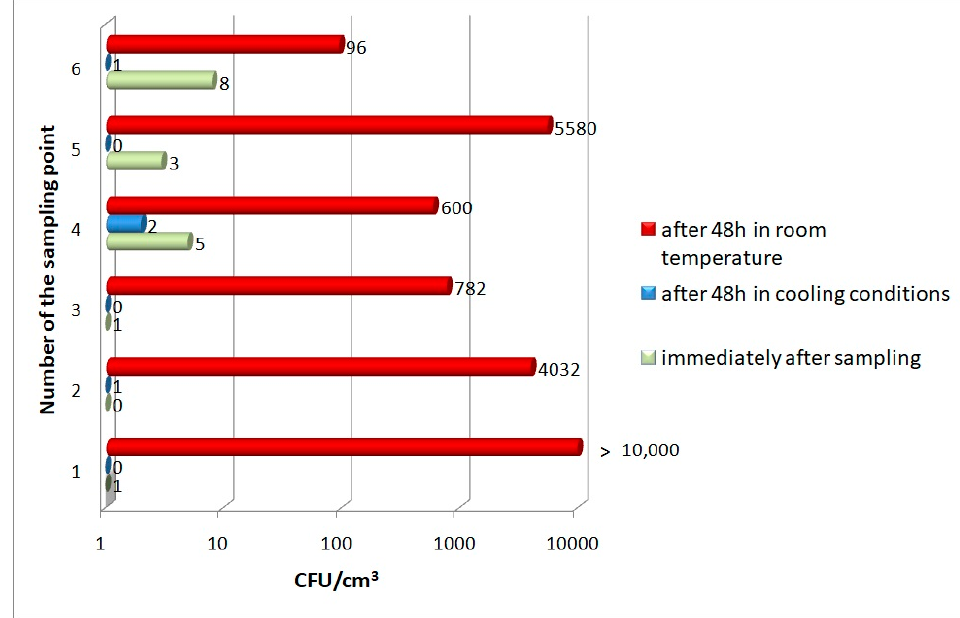
Figure 3. The numbers of mesophilic bacteria in Oligocene water samples.